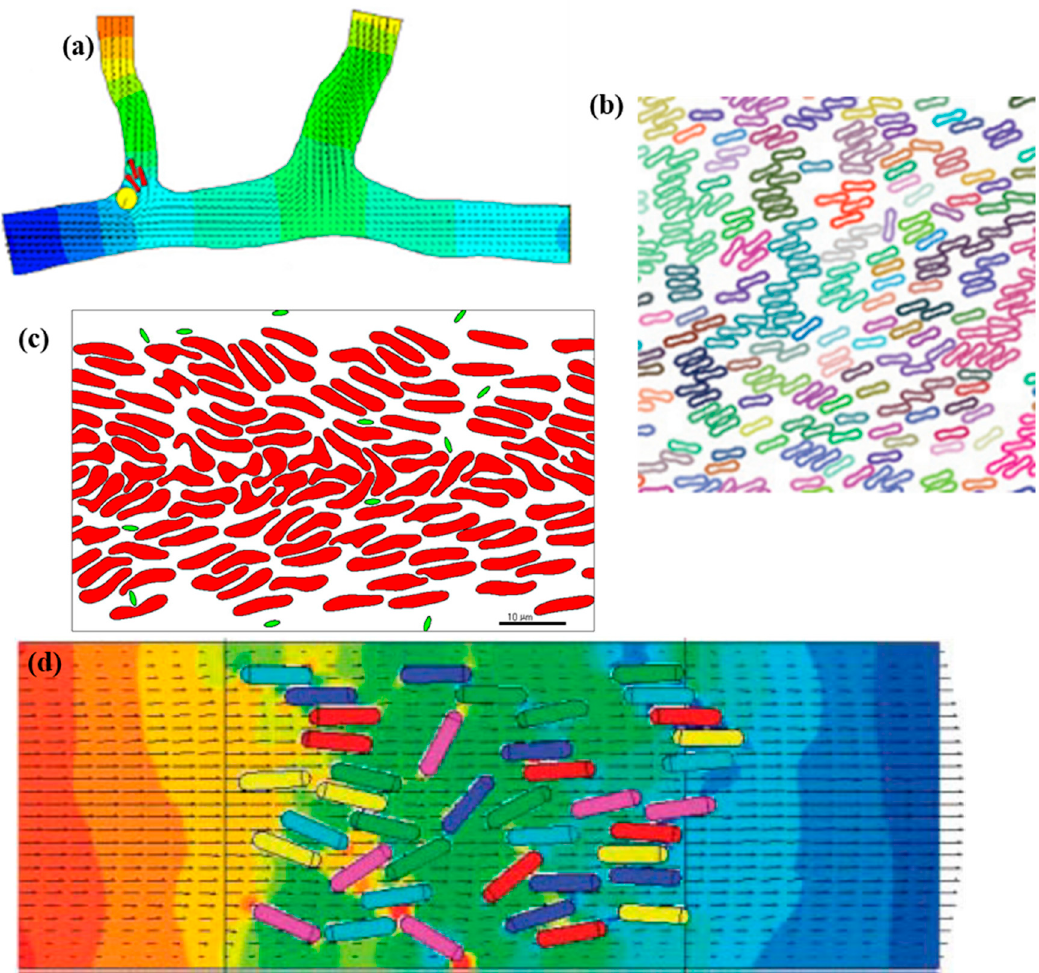
Figure 4. A few examples of past LBM simulations of blood cells in different domains. ( a ) Pressure and vector fields of three red blood cells (RBCs) flowing a white blood cell (WBC) in a blood vessel branch [65]. ( b ) Clusters distribution of RBCs in blood-like suspension [66]. ( c ) Simulation of the RBCs with platelets [67]. ( d ) RBCs simulated in a blood channel [68].